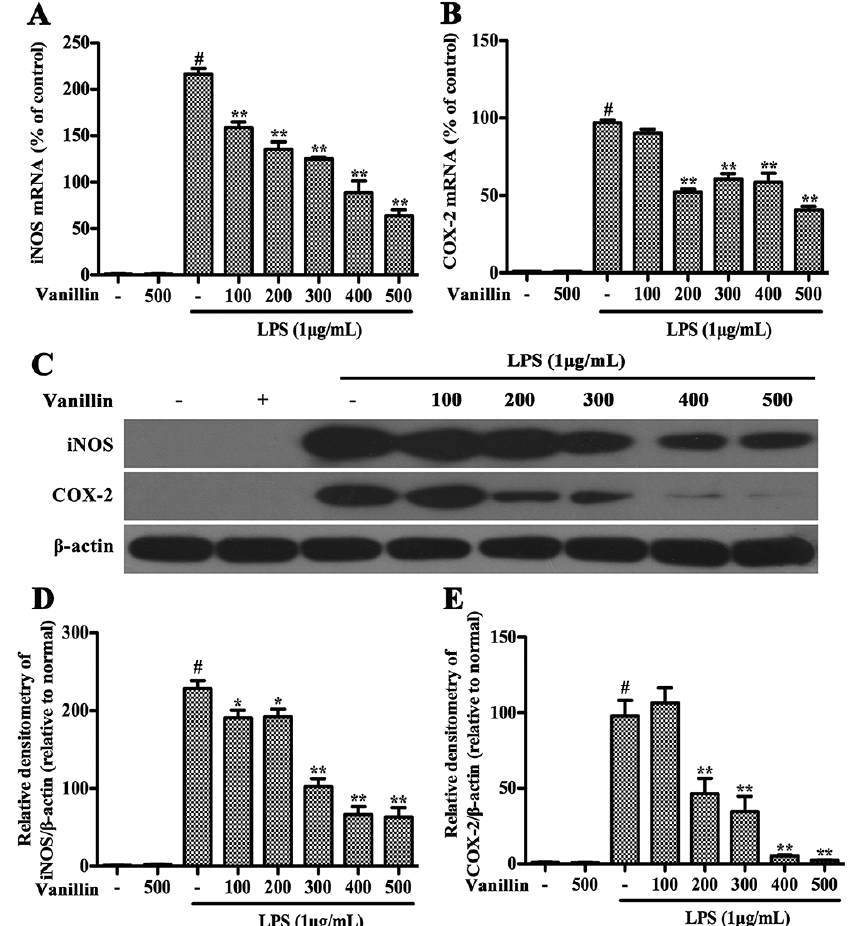
Figure 4. Vanillin attenuates the production of inducible nitric oxide (iNOS) and cyclooxygenase-2 (COX-2) induced by LPS in BV-2 cells. Cells were pretreated with vanillin (100, 200, 300, 400 and 500 nM) for 1 h and were then incubated with LPS (1 µg/mL) for 4 h. The mRNA levels of iNOS ( A ); and COX-2 ( B ) in BV-2 cells were examined by quantitative real-time PCR. The protein levels of iNOS ( C , D ) and COX-2 ( C , E ) were determined by Western blot. The data were normalized to β-actin. # p < 0.01 vs. no treated group. * p < 0.05 and ** p < 0.01 vs. the vanillin-untreated LPS-stimulated group.